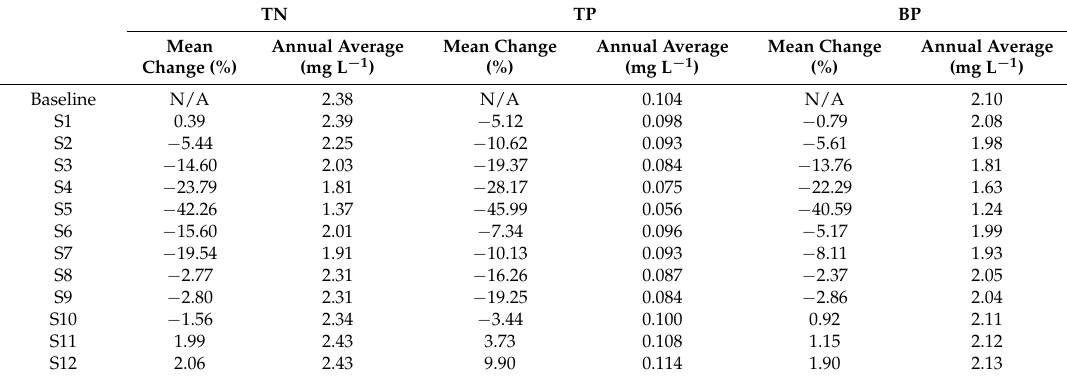
Table 5. Statistics for TN, TP, and BP under different management measures in the whole